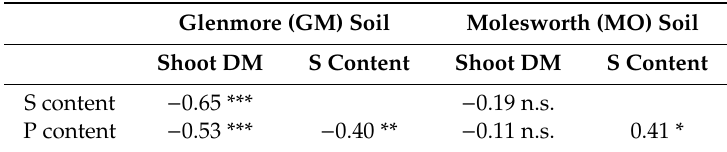
Table 7. Correlation matrices of the nutrient concentrations (g kg − 1 of shoot DM) and shoot DM yield (g) produced in GM and MO